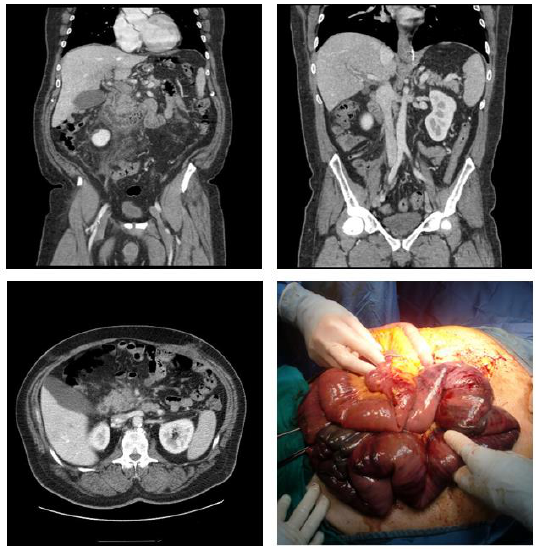
Figure 4. Case of portal vein thrombosis after biliopancreatic diversion; CT scan showing extended PVT associated with bowel ischemia, and related intraoperative findings. PVT: Portal Vein Thrombosis .